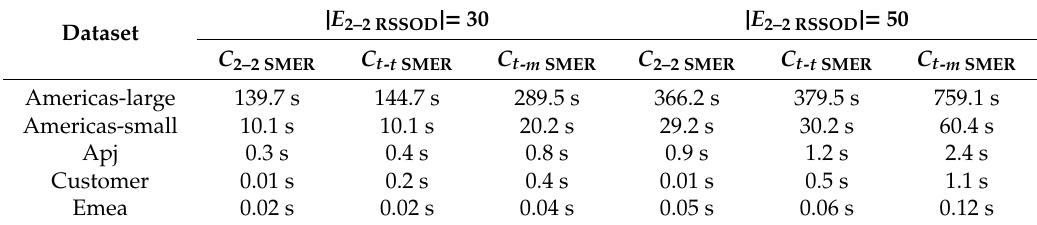
Table 11. Execution time with 2–2 RSSOD.